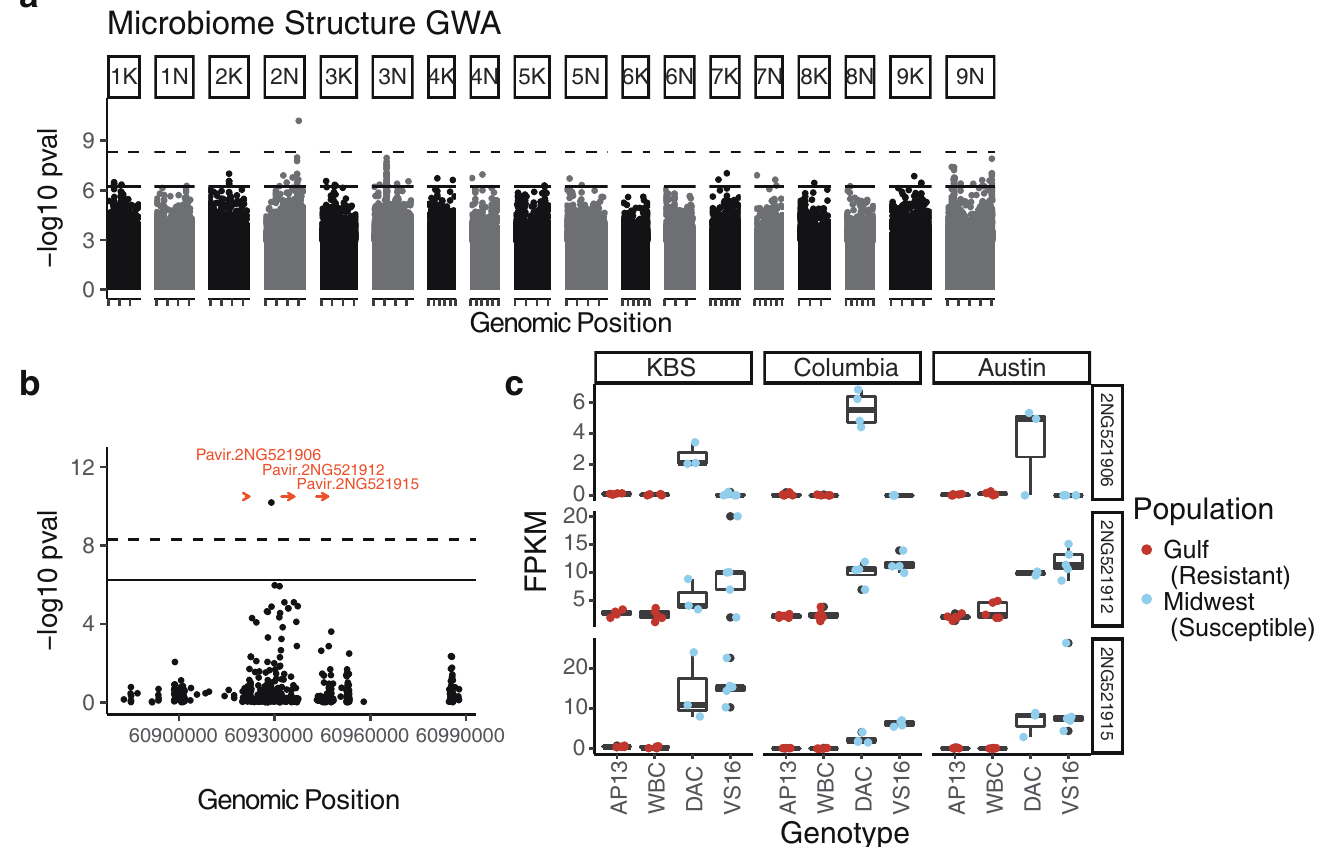
Fig 4. Genetic associations with microbiome structure. (A) GWAs of microbiome structure (NMDS2 at DOY 260). The lower solid line shows the 5% FDR threshold, and the upper dashed line shows the Bonferroni-adjusted alpha threshold for SNPs associated with the microbiome. (B) Outlier region on Chromosome 2N with nearby genes shown in red. (C) Expression-level differences for genes shown in (B). Leaf tissue for these samples was collected as part of a different study, performed at 3 of the same sites we used. FPKM are scaled differently in each gene facet. Data underlying this figure can be found in S4 Data. DOY, day of year; FDR, false discovery rate; FPKM, fragments per kilobase of transcript per million mapped reads; GWA, genome-wide association; NMDS, nonmetric multidimensional scaling; SNP, single nucleotide polymorphism. https://doi.org/10.1371/journal.pbio.3001681.g004 time points, KBS, Michigan. Fungal microbiomes in these samples conformed closely to our predictions, with allelic variation at the Chr02N_57831909 locus influencing microbiome structure (PERMANOVA F = 1.84, p = 0.016, R 2 = 0.064; S7 Fig). Although this was a smaller subset of samples taken 3 years after the original samples, we were also able to confirm a strong temporal influence on microbiome structure between the 2 time points (PERMANOVA Table 2. Wald test for expression differences in 3 candidate genes between Midwest (more susceptible) and Gulf (more resistant) populations. Wald test Base mean